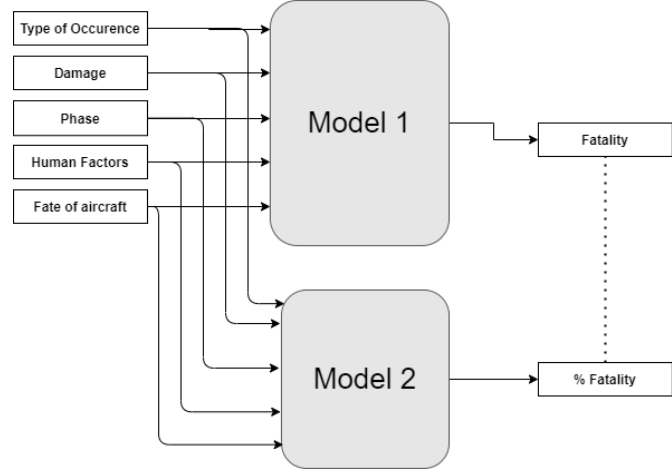
Figure 4. Schema of the database